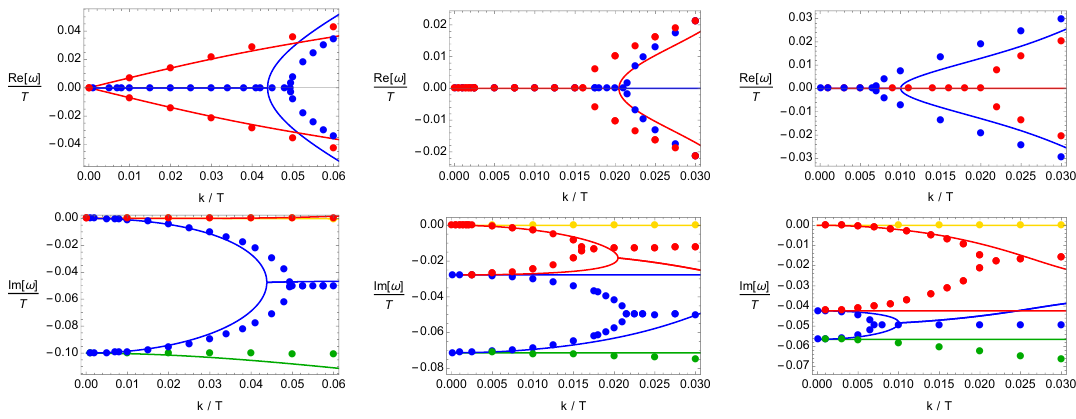
Figure 5 . Dispersion relation of the low-energy modes. Left, center and right panels correspond respectively to µ/T = 0 , 0 . 5 , 0 . 55 .